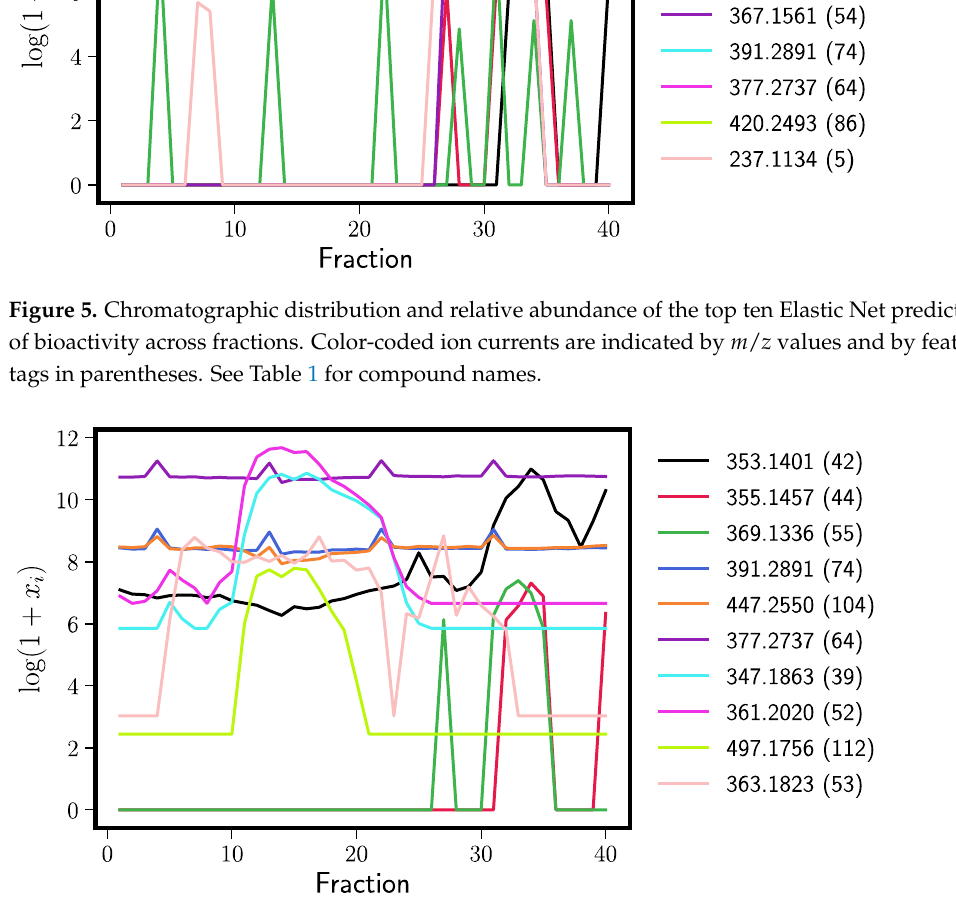
Figure 6. Chromatographic distribution and relative abundance of the top ten Random Forest predictors of bioactivity across fractions. Color-coded ion currents are indicated by m / z values and feature tags in parentheses. See Table 1 for compound names.